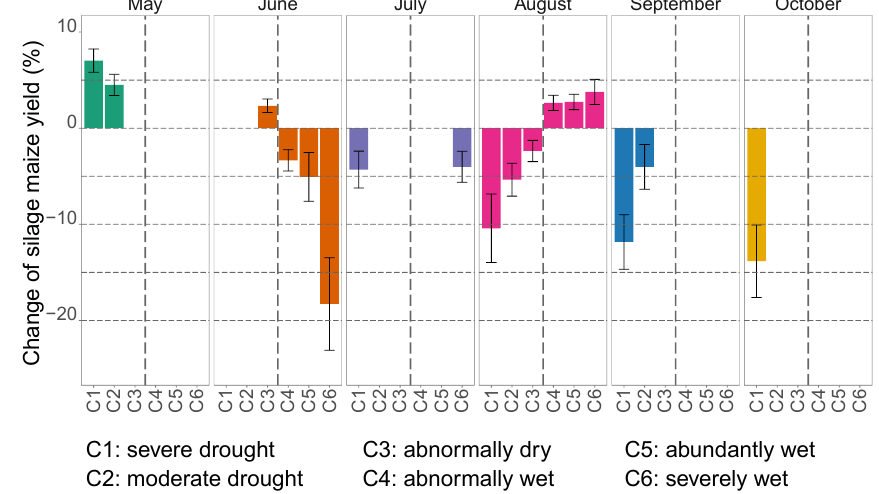
Figure 5. Percentage change of silage maize yield caused by significant soil moisture anomalies for each month. The vertical axis represents the change in silage maize converted into percent, approximated by the formula 100(exp ( moisture classes (refers to Eq. 2). The standard errors are indicated by the black error